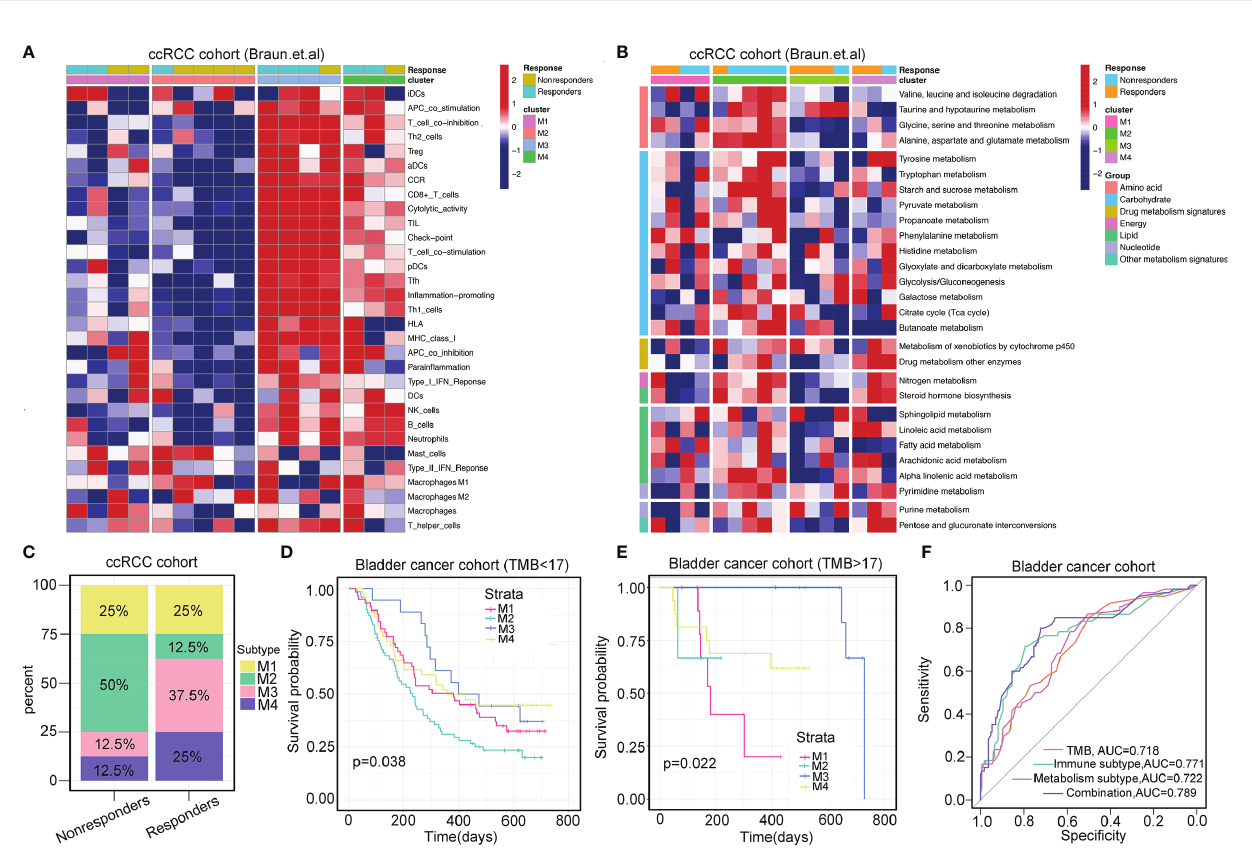
FIGURE 5 | Immunometabolism subtypes correlate with immunotherapy. (A, B) Heatmaps show the immune landscape and metabolism signatures of four immunometabolism subtypes in ccRCC prior to anti-PD-1 therapy (Baun et al.). (C) Percentages of four immunometabolism subtypes in responders and non- responders prior to anti-PD-1 therapy in ccRCC. (D, E) Strati fi cation survival analysis of TMB <17 and TMB >17 across four subtypes in bladder cancer (IMvigor210 cohort). p -value is given by log-rank test. (F) Receiver operating characteristics of predicting the response of anti-PD-1 therapy in bladder cancer based on the TMB and immunometabolism